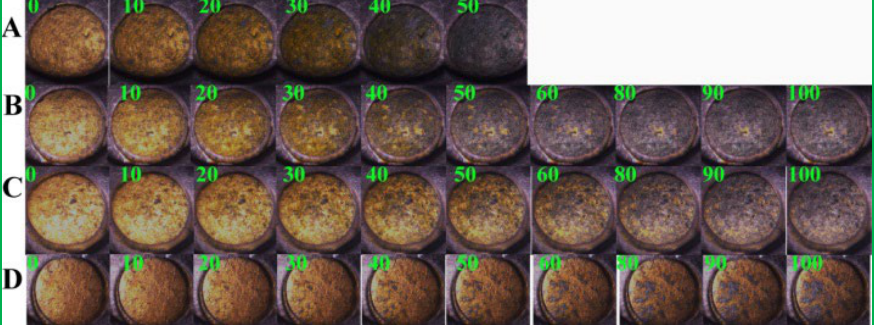
Figure 6. Dissolution of Au film at the anode of the BPE when the cathode of the GP BPE was modified with Au ( A ), Ab 1 /Au ( B ), SiO 2 -Ab 2 /PSA (10 ng/mL)/Ab 1 /Au ( C ), and SiO 2 -Ab 2 /PSA (100 ng/mL)/Ab 1 /Au ( D ). The external voltage was 3.0 V.